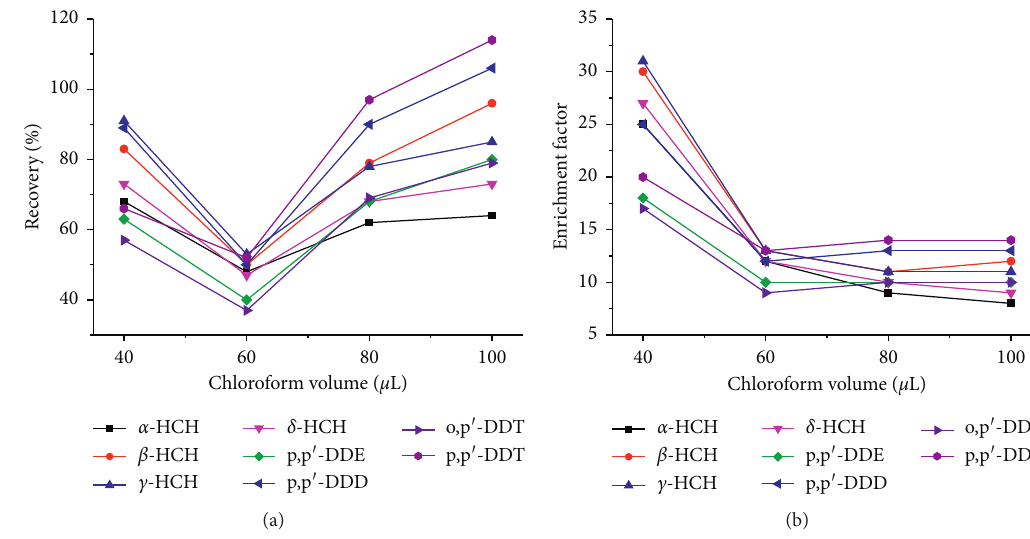
Figure 5: Effect of chloroform volume on OCPs recoveries (a) and enrichment factors (b). Table 2: Linear range, linear equation, LOD, LOQ, and enrichment factor of 8 OCPs.